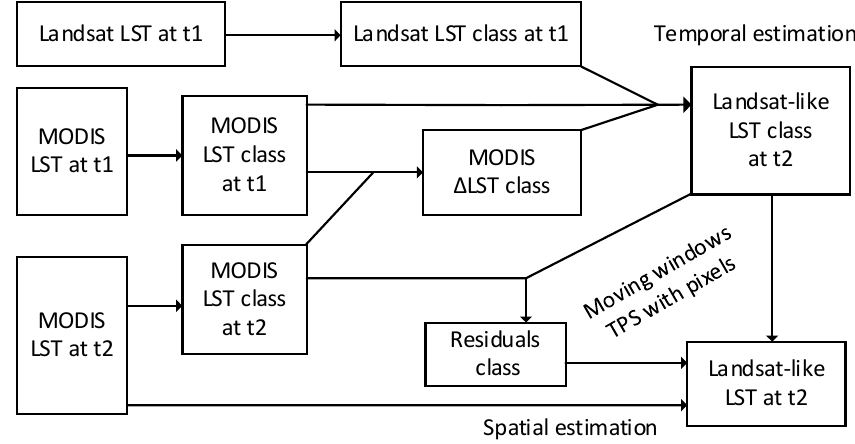
Figure 2. Flowchart of the Landsat-like LST generation procedure.